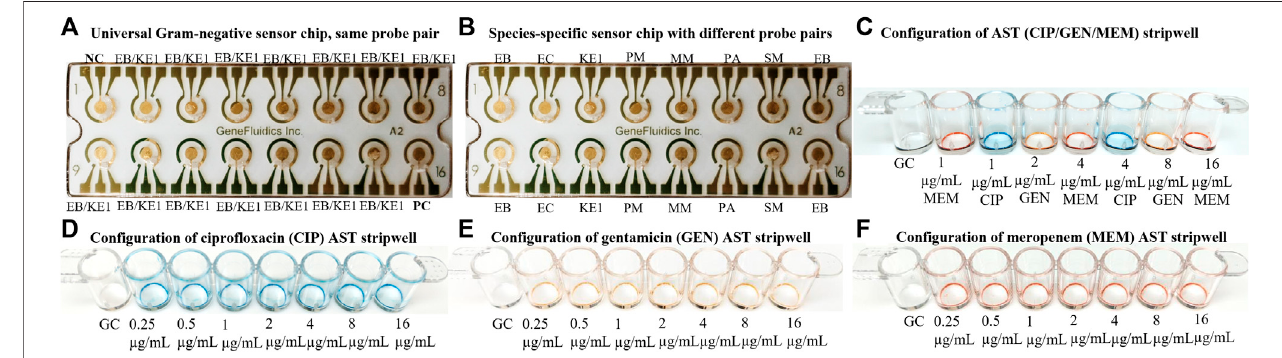
FIGURE 4 | (A) Sensor con fi guration of the same probe pair (EB/KE1 for most clinically relevant Gram-negative strains including Enterobacterales and Pseudomonas aeruginosa . EB capture probe: 5 ′ -ACTTTATGAGGTCCGCTTGCTCT-3 ′ , EB detector probe: 5 ′ -CGCGAGGTCGCCTTCCTTTGTAT-3 ′ , KE1 capture probe: 5 ′ -GCACTTTATGAGGTCCGCTTGCTCT-3 ′ , KE1 detector probe: 5 ′ -CGCGAGGTCGCTTCTCTTTGTATGC-3 ′ ) for measurement of 16S rRNA from the same species with different conditions such as calibration curve and antimicrobial responses. (B) Sensor con fi guration of different probe pairs for detection of species- speci fi c 16S rRNA of a polymicrobial sample. NC stands for Negative Control and PC stands for Positive Control. Additional probe pairs (EC, KE1, MM, PA, SM) can be added for a customized panel for Escherichia coli , Pseudomonas aeruginosa , Serratia marcescens , Morganella morganii , Klebsiella pneumoniae , Klebsiella oxytoca , Enterobacter cloacae , Klebsiella aerogenes, and Citrobacter freundii to quantify 16S rRNA content individually. (C, D) Example of two con fi gurations of antibiotic stripwells to be used in this study. (E, F) Additional con fi gurations of antibiotic